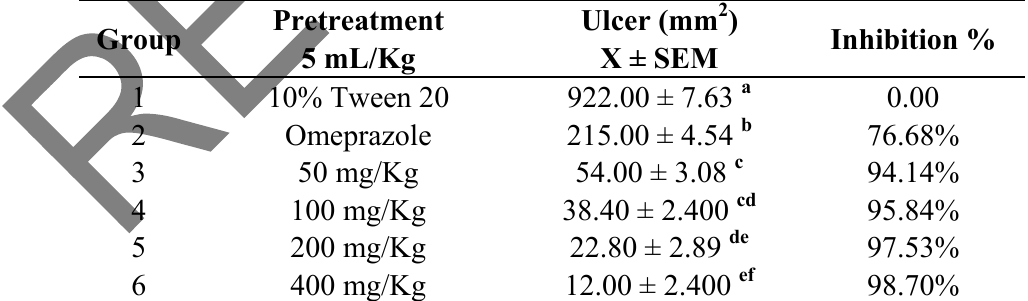
Table 3. Observed ulcer area and inhibition percentage of BClHC in rats. Values are means ± SEM of six